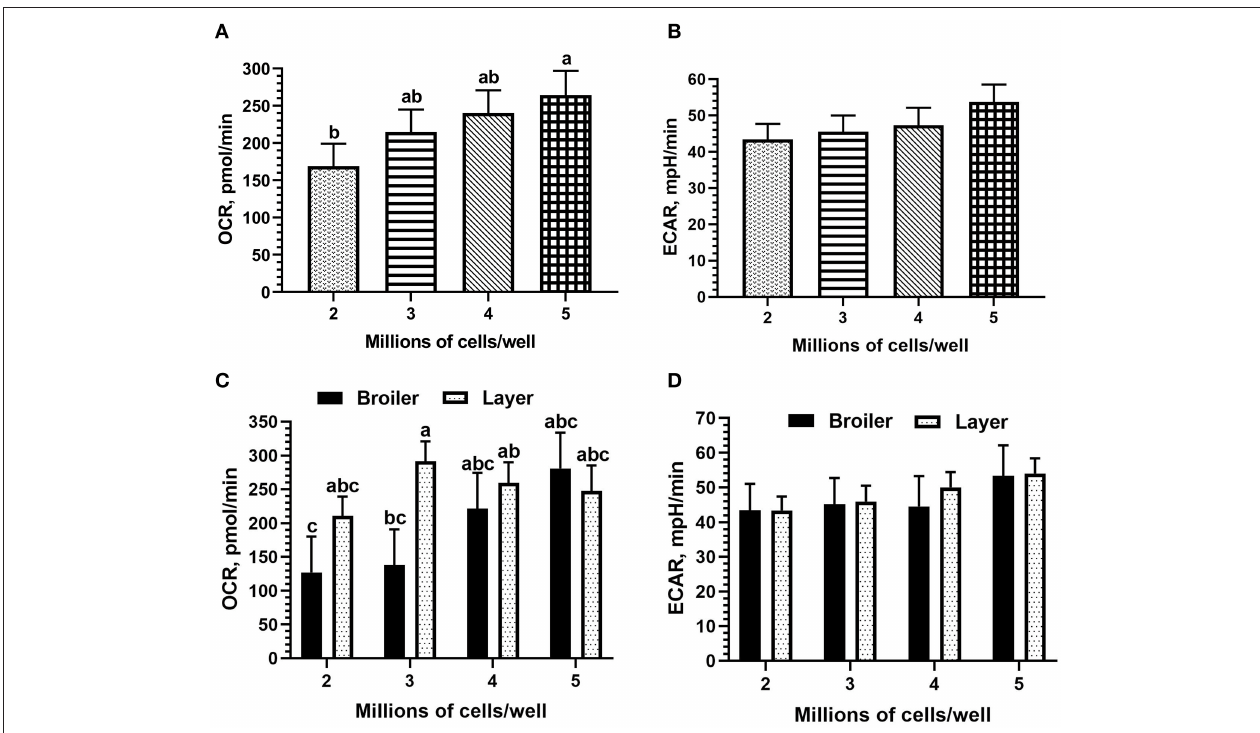
FIGURE 1 | Cell seeding density titrations for optimal results using fresh chicken peripheral blood mononuclear cells (PBMCs) (Ross 308 broiler and Bovans layer) in the Seahorse Xfe24 Analyzer (Agilent) by main effect of cell seeding density on (A) oxygen consumption rate (OCR) and (B) extracellular acidification rate (ECAR), and by the cell seeding density x line of bird interaction on (C) OCR and (D) ECAR. All data are presented as least square means (LSMeans 1 ) (SEM). 1 Bars that do not share letters indicate means that are significantly different ( p ≤ 0.05).